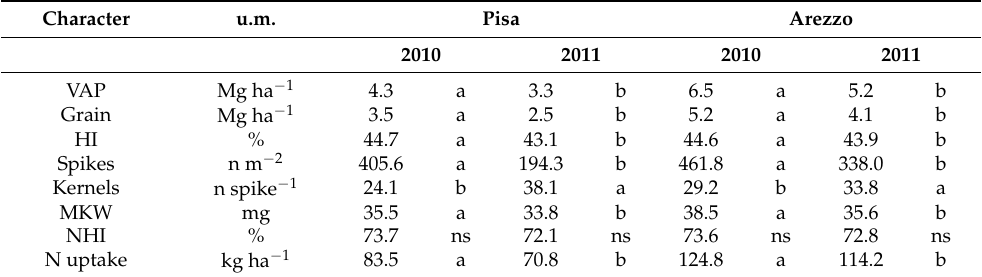
Table 3. Dry weight of vegetative above ground parts (VAP), grain yield, Harvest Index (HI), yield components and Nitrogen Harvest Index (NHI) and total N uptake as affected by Year (Y), at Pisa and Arezzo. For each location, values followed by different letters within lines are significantly different, values followed by ns are not significantly different ( p < 0.05).